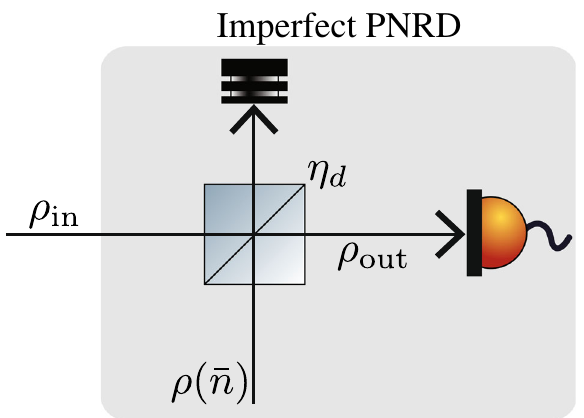
Fig. 7 Diagram of the method used to simulate the effect of dark counts in the PNRDs. ρ in is the density matrix of the input state. The grey box represents a realistic photon number resolving detector with ef fi ciency η d and dark noise ð 1 (cid:2) η d Þ n .